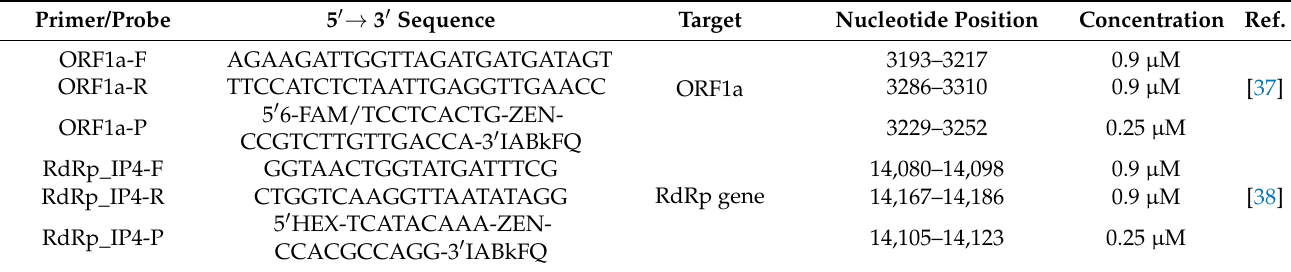
Table 1. Primer and probe sets included in the multiplex RT-ddPCR